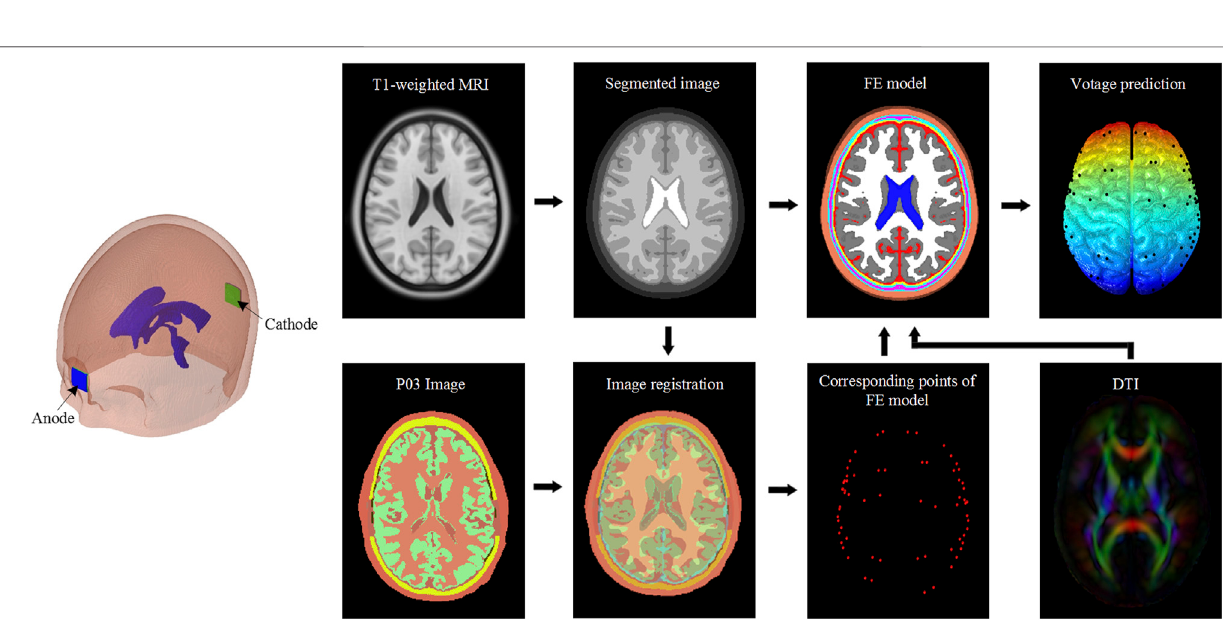
FIGURE 2 | Model validation work fl ow. Patient images obtained from in vivo experiments (Huang et al., 2017) are af fi nely registered to the segmented images correspondingtotheFEmodelused inthestudy. Theobtainedaf fi netransformation matrix isthen usedtotransform the recording electrodescoordinates ofthepatient to corresponding points of the FE head model. The diffusion tensor is used to derive the WM anisotropic conductivity. The FE head model and anisotropic conductivity tensor are then used to analyze the voltage distribution. The predicted values of voltage and calculated electric fi eld are compared with in vivo experiments data reported by Huang et al.